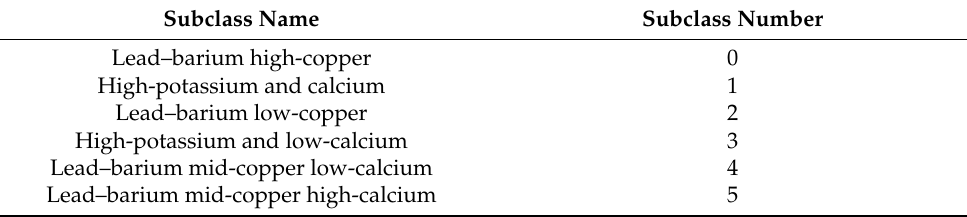
Table 4. Subclass results obtained by the K-Means++ clustering algorithm.